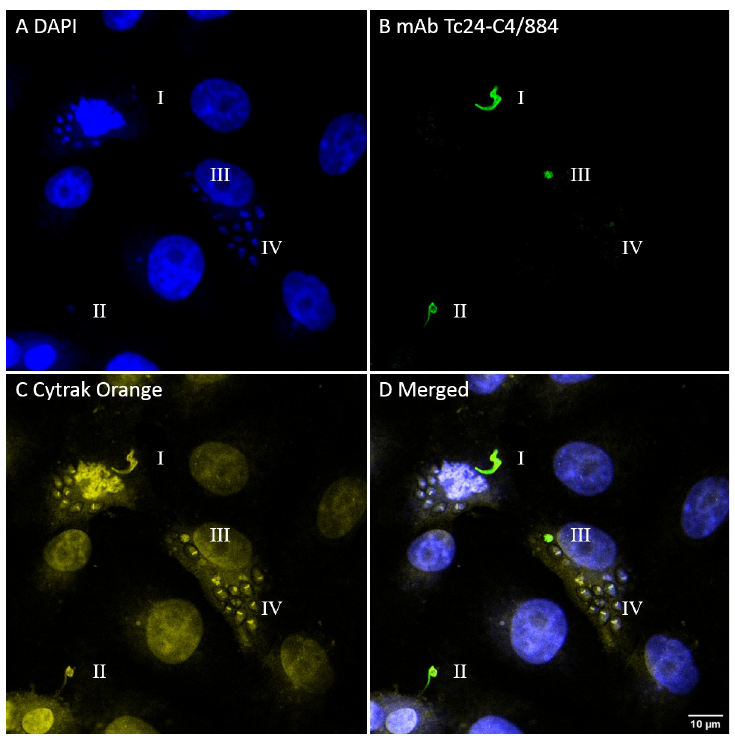
Fig 4. Fluorescence confocal microscopy images of VERO cells infected with T . cruzi showing the different Tc24 expression in parasitic stages. Different transitions between trypomastigote and amastigote can be observed in I, II, III and IV. I: trypomastigote, II: trypomastigote with reduced flagella, III: complete transition to amastigote, IV: amastigotes with multiple divisions. A) In blue, DAPI nuclear stain. B) In green, mAb Tc24-C4/884 stained by goat anti-mouse IgG (H+L) Alexa Fluor 488. C) In yellow, CyTRAK Orange DNA and cytoplasmic stain. D) Merged image of A-C. Pixel size of images: 102 nm x 102 nm.